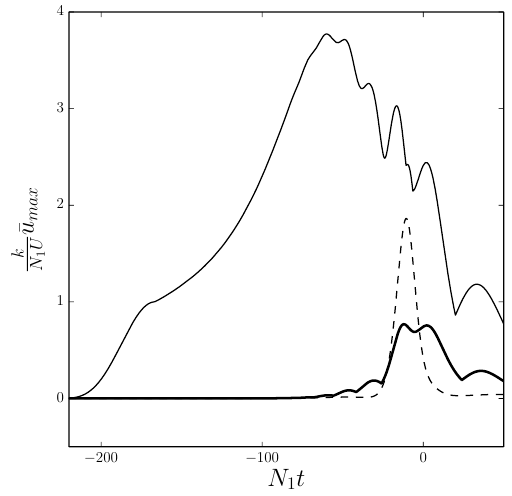
Figure 16. Time history of the maximum of the mean flow. The dashed line is the velocity jump at the interface while the thick solid line that is the maximum the interference mean u i . The parameter values are n 1 /k = 0.4, N 2 /N 1 = 2, (cid:15) = 0.025, and α = 0.1.